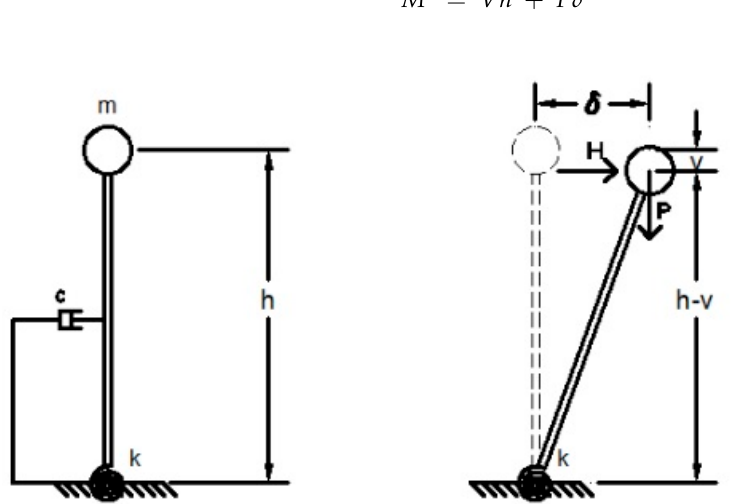
Figure 4. Concept of P-delta effect: example of single degree of freedom.